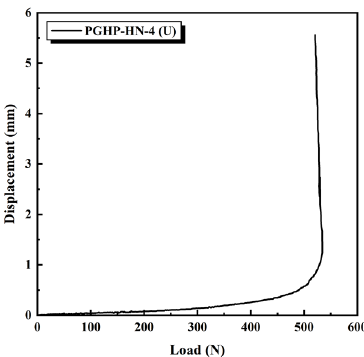
Figure 13. Load–settlement curves of uplift: helix number test sets. Table 4. Ultimate bearing capacity estimated from the load–settlement curves.